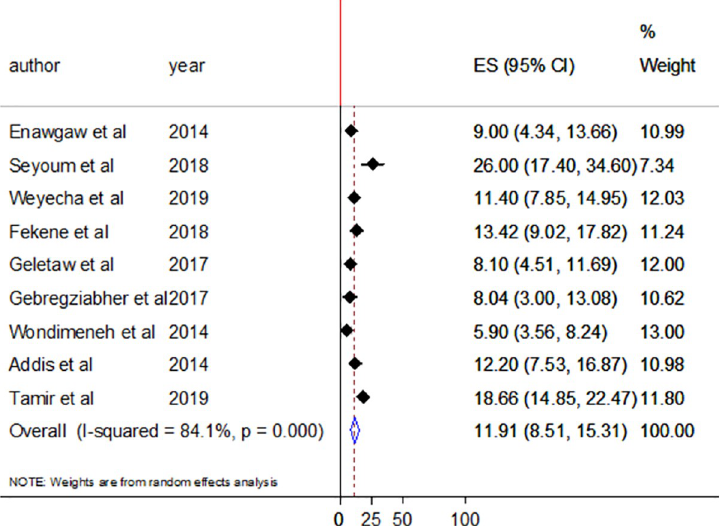
Fig 3. Forest plot showing the pooled prevalence of thrombocytopenia among HAART na ï ve HIV/AIDS patients.